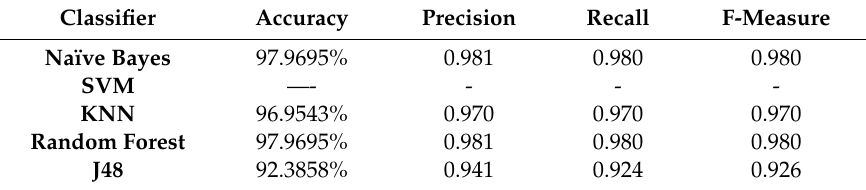
Table 5. Performance metrics for all TX–RX as di ff erent cases (1896 features per case).